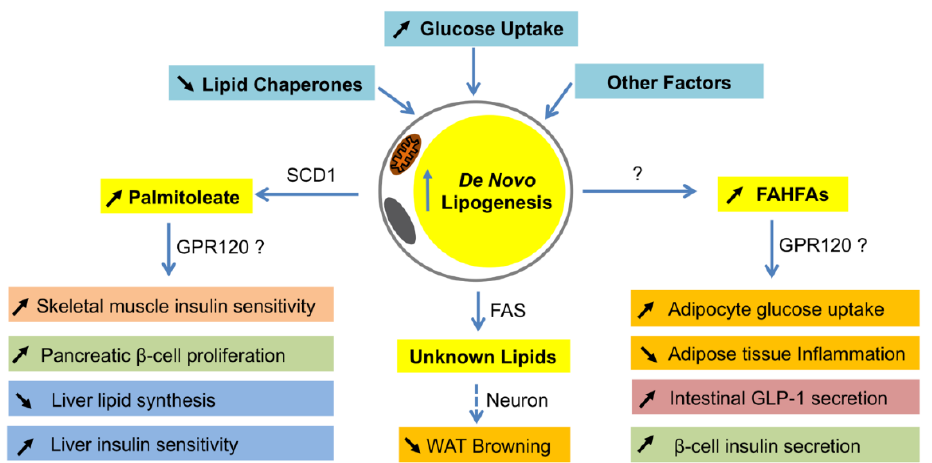
Figure 2. Systemic effects of lipokines produced by de novo lipogenesis in adipocytes. When de novo lipogenesis is increased in adipocytes by means of increasing glucose uptake, decreasing lipid chaperones, or others, some bioactive fatty acids such as palmitoleate and fatty acid ester of hydroxyl fatty acids (FAHFAs) are produced. As a product of SCD1 in adipocytes, palmitoleate functions to improve insulin sensitivity in skeletal muscle and liver, promote pancreatic β -cell proliferation, and inhibit lipid synthesis in the liver. Although it is unclear how FAHFAs are synthesized in adipocytes, these lipids have a function to stimulate adipocyte glucose uptake, intestinal glucagon-like peptide-1 (GLP-1) secretion and β -cell insulin secretion, and reduce inflammation in adipose tissues. The metabolically beneficial effects of palmitoleate and FAHFAs are probably through G protein-coupled receptor 120 (GPR120). In addition, FASN may produce some unknown lipid products in white adipocytes that function to inhibit white fat browning through neuronal circuit regulation. WAT—white adipose tissues.